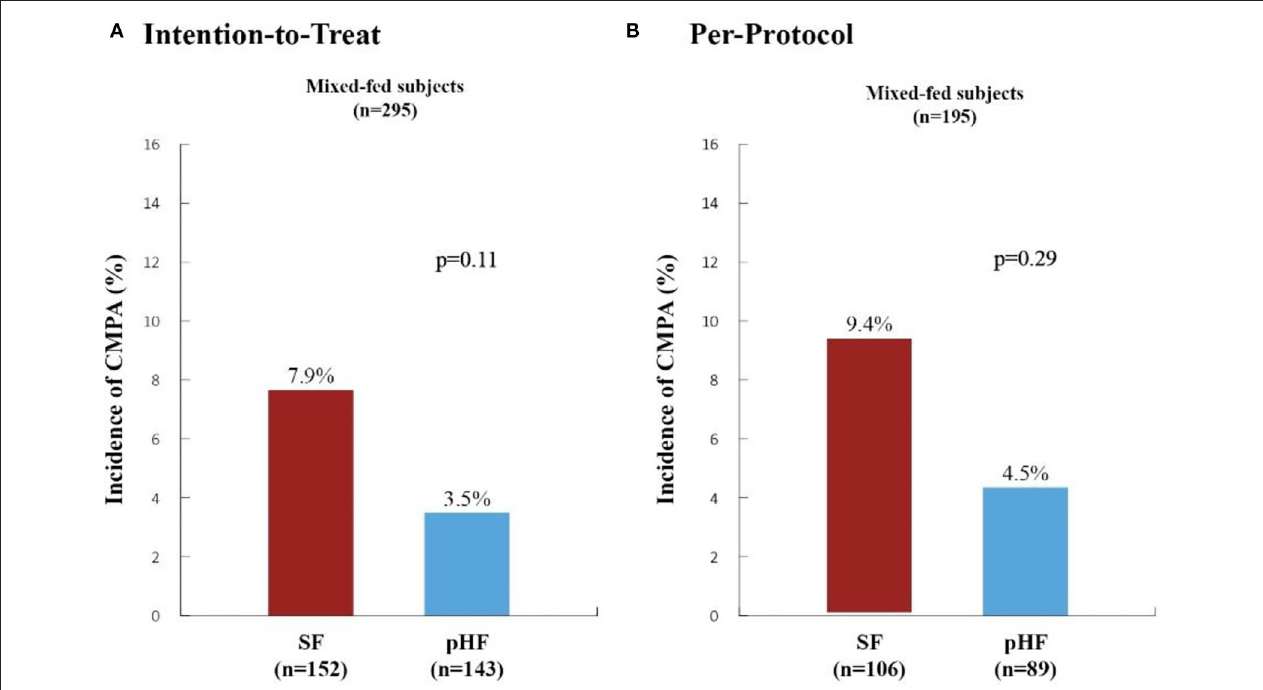
FIGURE 2 | Incidence of Cow’s Milk Protein Allergy within the first six months of life in high-risk mixed-fed infants. The incidence of cow’s milk protein allergy (CMPA) in high-risk mixed-fed infants within the first 6 months of life as generated from Poisson generalized estimating equation (GEE) regression analysis (adjusting for study center, gender and type of formula) are presented in the Intention-to-Treat (A) and Per-Protocol (B) Analyses. SF, standard formula (red columns); pHF, partially hydrolyzed formula (blue columns). The incidence of CMPA observed in the SF group compared to the pHF was higher in both analyses (ITT: 7.9 vs. 3.5%, p = 0.11 and PP: 9.4 vs. 4.5%, p = 0.29) although the difference did not reach statistical